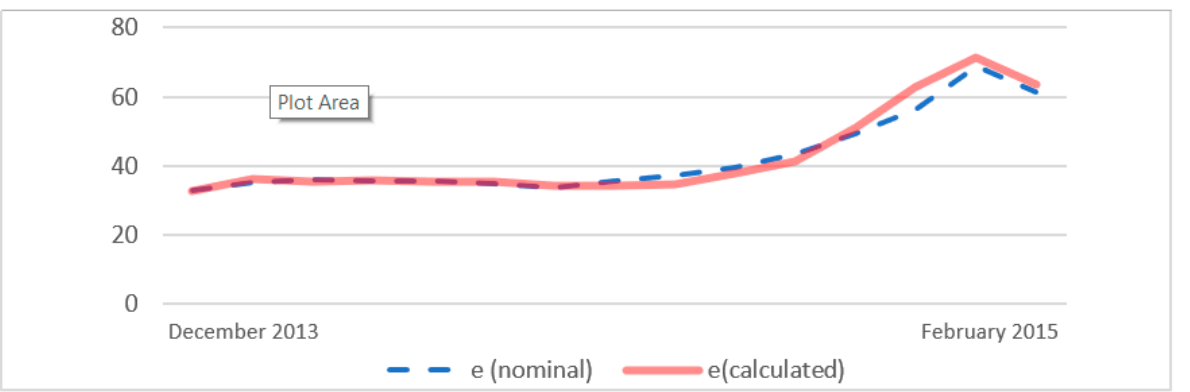
Figure 3. Calculated and nominal USD/RUR exchange rates (December 2013–February 2015, author’s calculations, monthly data).